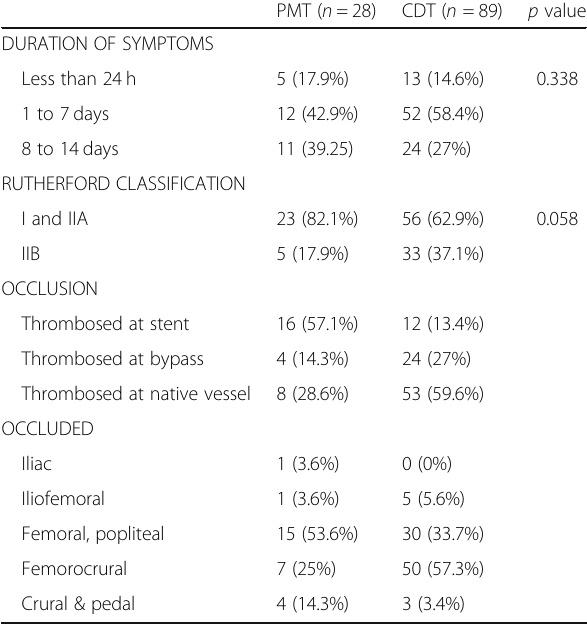
Table 2: Clinical presentation and location of occlusion